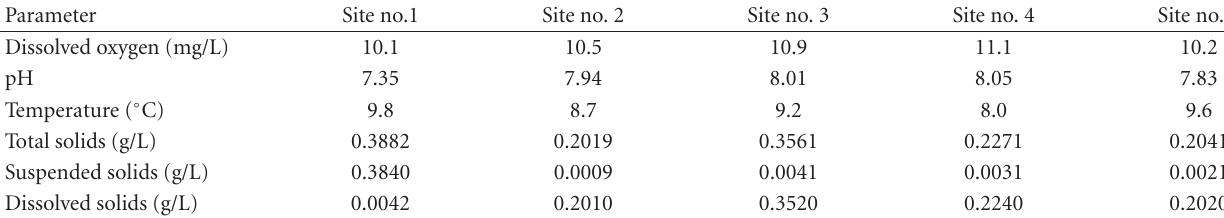
Table 6: Field results of master variables for river water samples for the month of